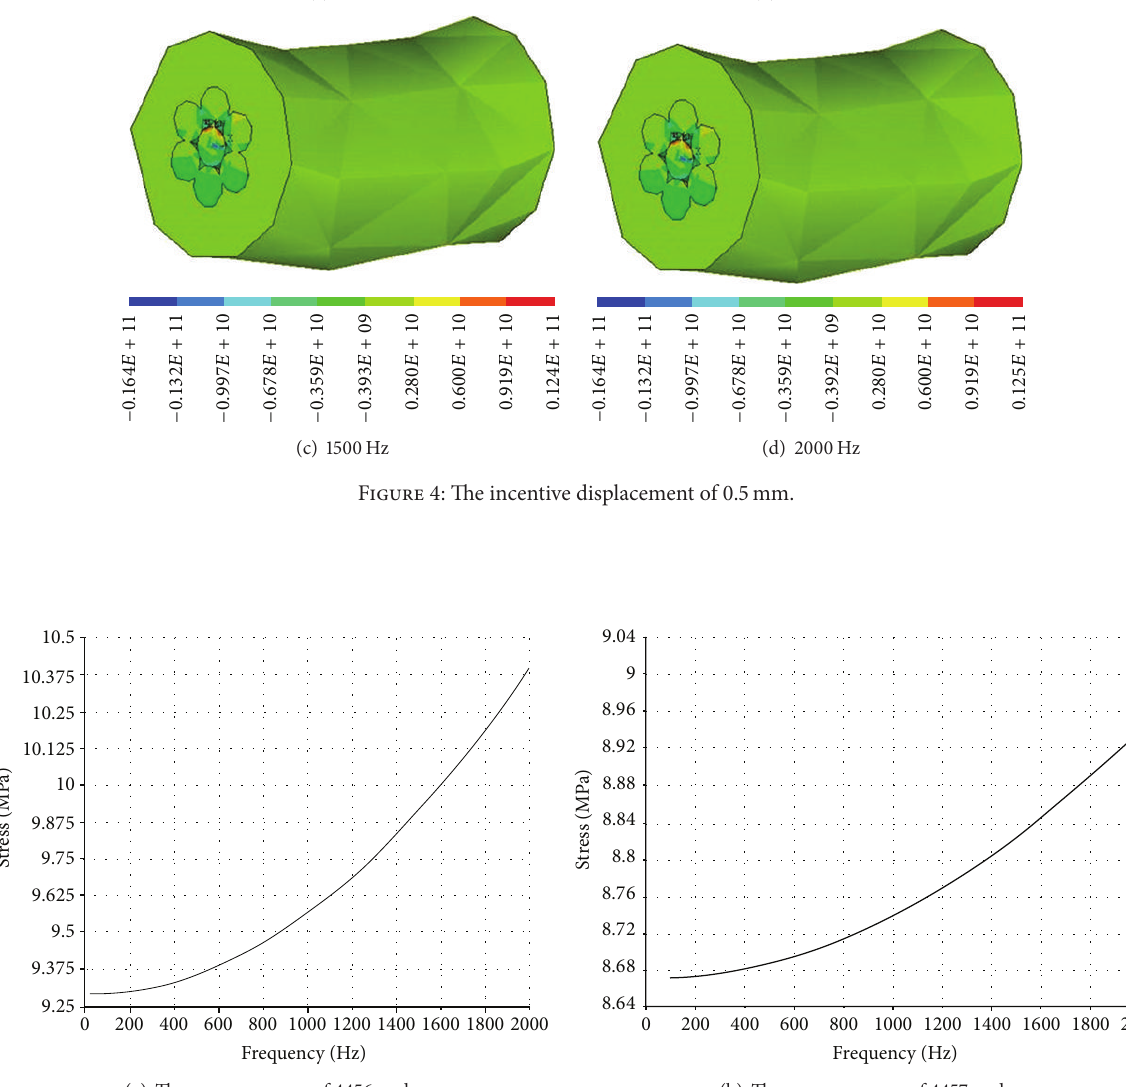
(b) The response curve of 4457 node Figure 5: The displacement response curve of 0.25